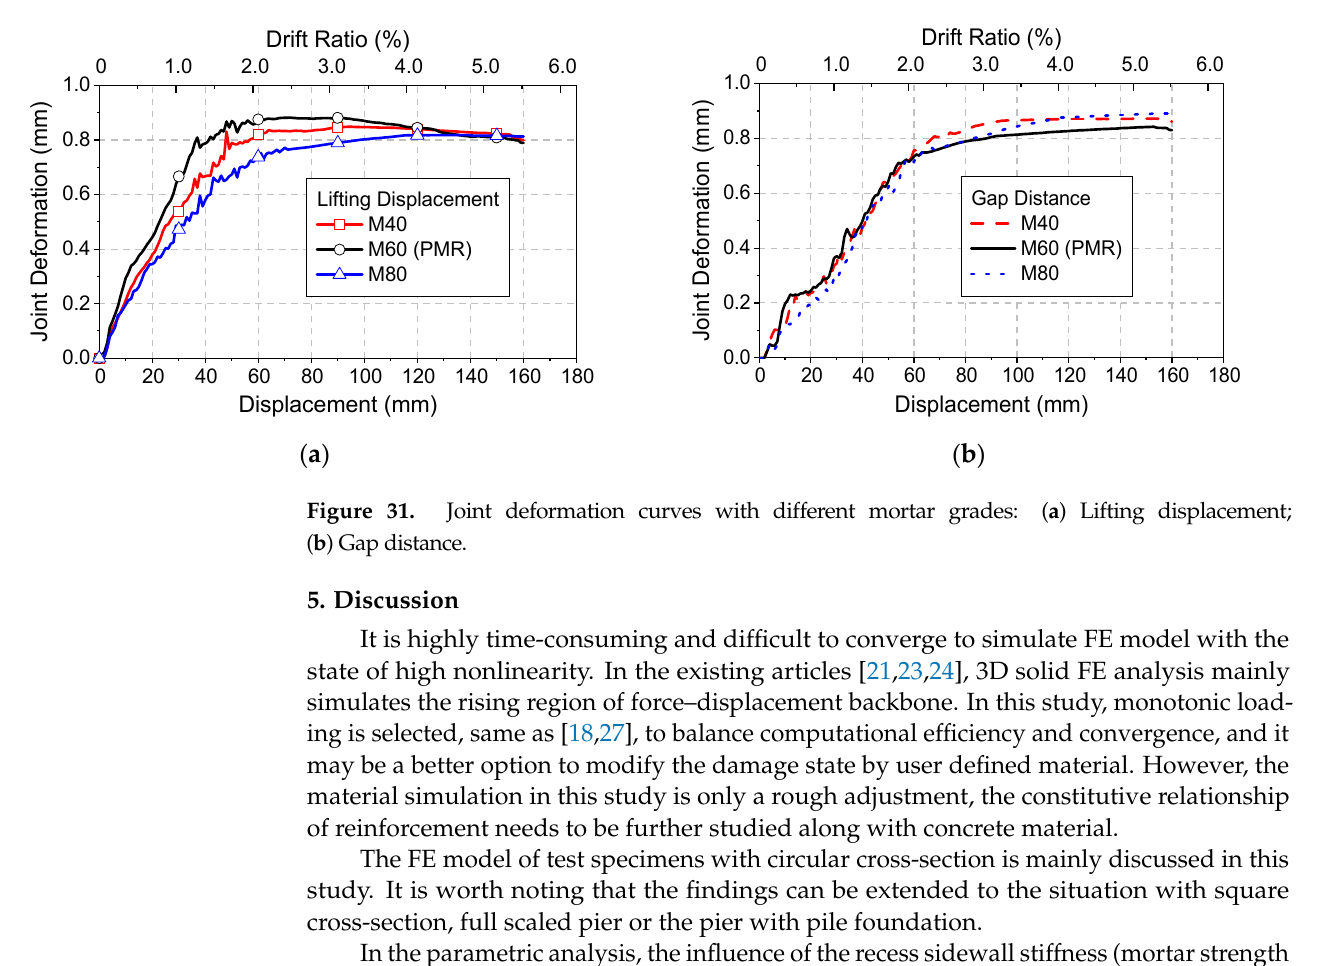
Figure 30. Maximum mortar stress with different mortar grades.